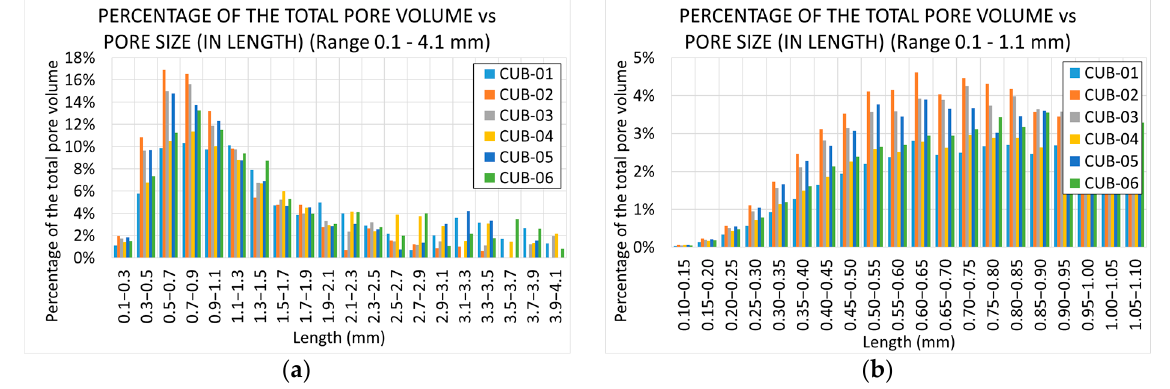
Figure 22. Histograms of pore-volume distribution (in length).